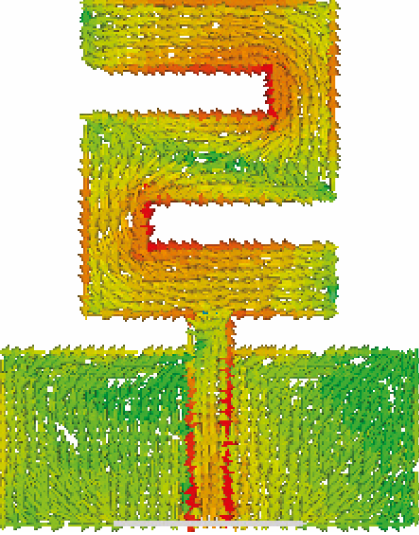
in dB of the Z-shaped 11 Figure 8: Simulated current distribution of the antenna at 2.45